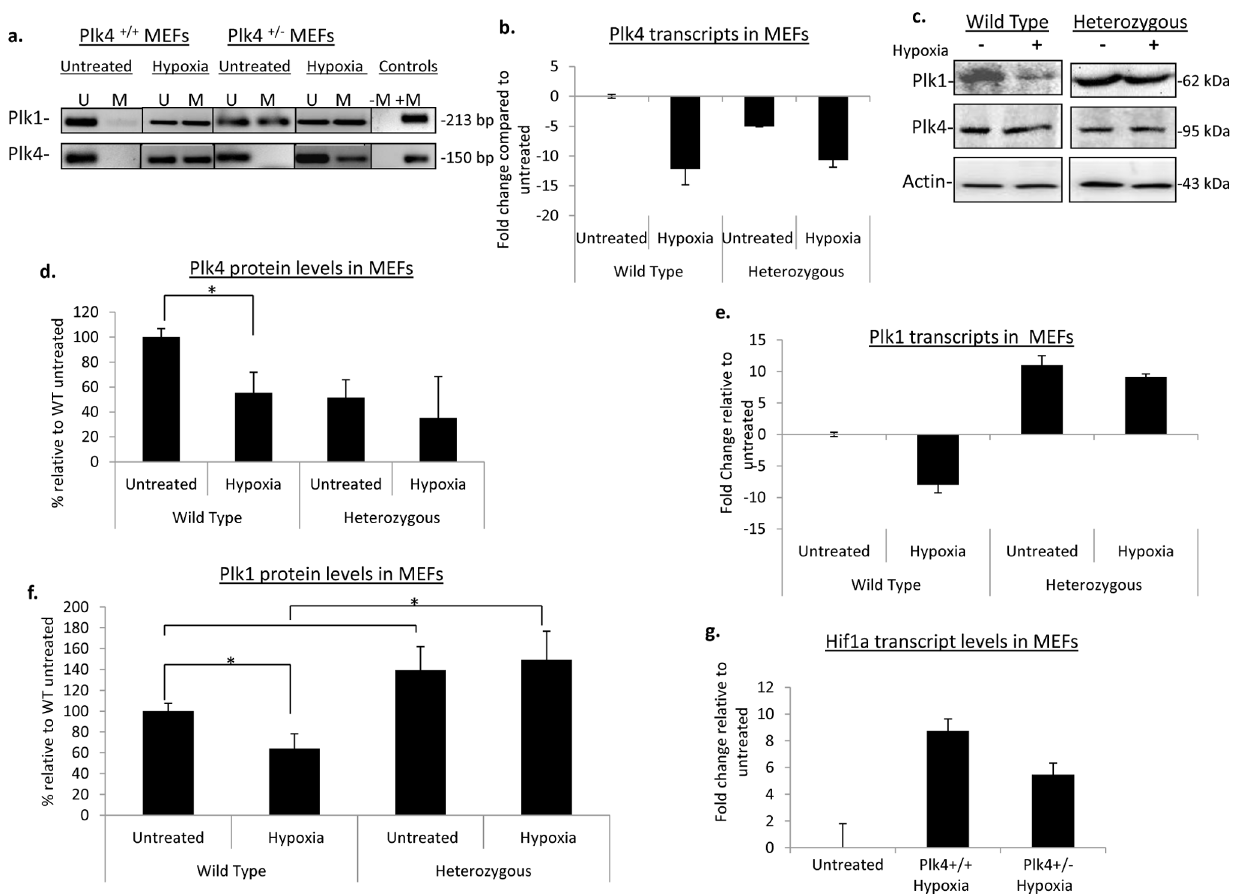
Figure 1. Aberrant methylation of plk1 and plk4 promoter regions in MEFs under hypoxic stress. (a) DNA extracted from mouse embryonic fibroblasts grown under hypoxic conditions was bisulfite treated and then assessed for promoter methylation of Plk1 and Plk4 using methylation specific PCR; U=unmethylated, M=methylated. Fully methylated NIH 3T3 DNA was used as a positive control ( + M), no template was added to the negative control ( 2 M). (b) Plk4 transcripts were assessed using qPCR. Transcript levels were normalized to the wild type untreated sample. All qPCR data is representative of the mean value of three independent experiments and error bars represent + / 2 SD. (c) Western blot analysis to examine protein levels of Plk1 and Plk4 post hypoxic treatment. ( 2 ) represents the lysates from untreated cells, ( + ) lysates from cells were grown in the presence of hypoxia. (d) Densitometric analysis normalized to the levels of the wild-type untreated cells. Error bars represent + / 2 SD from three independent experiments. (e) The fold change of plk1 transcripts normalized to the respective untreated transcripts. (f) The percent of Plk1 protein expression relative to the untreated wild-type cells. * denotes significance with p , 0.05. (g) RNA extracted from MEFs along with real- time PCR was used to determine Hif1 a transcripts post hypoxia